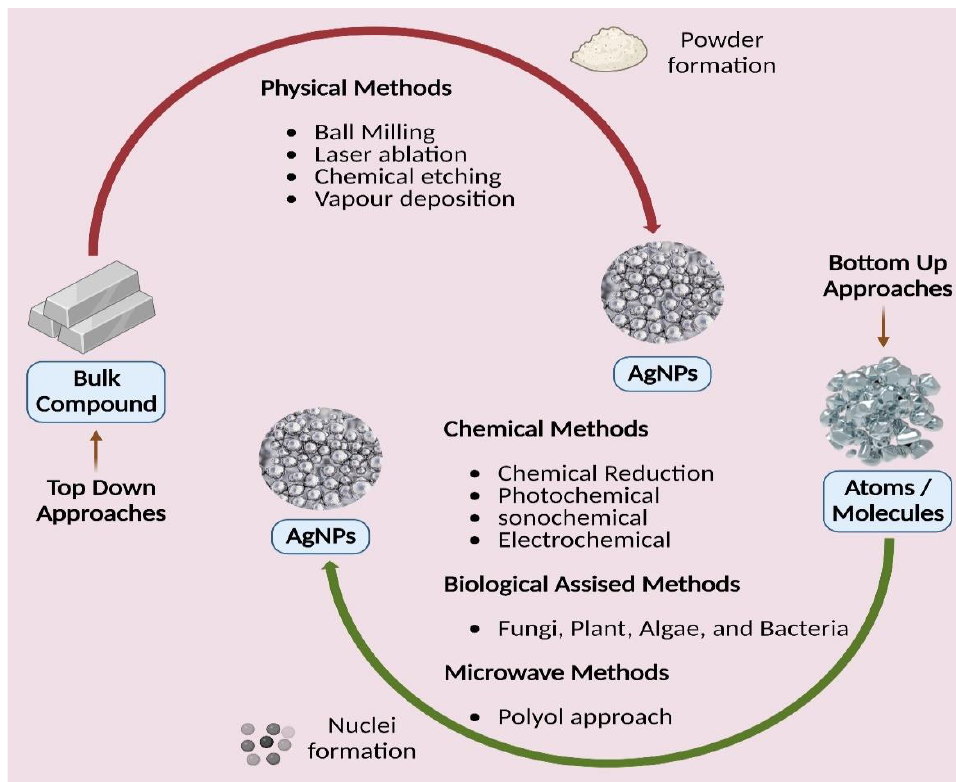
Figure 5. Different approaches of silver nanoparticles synthesis.